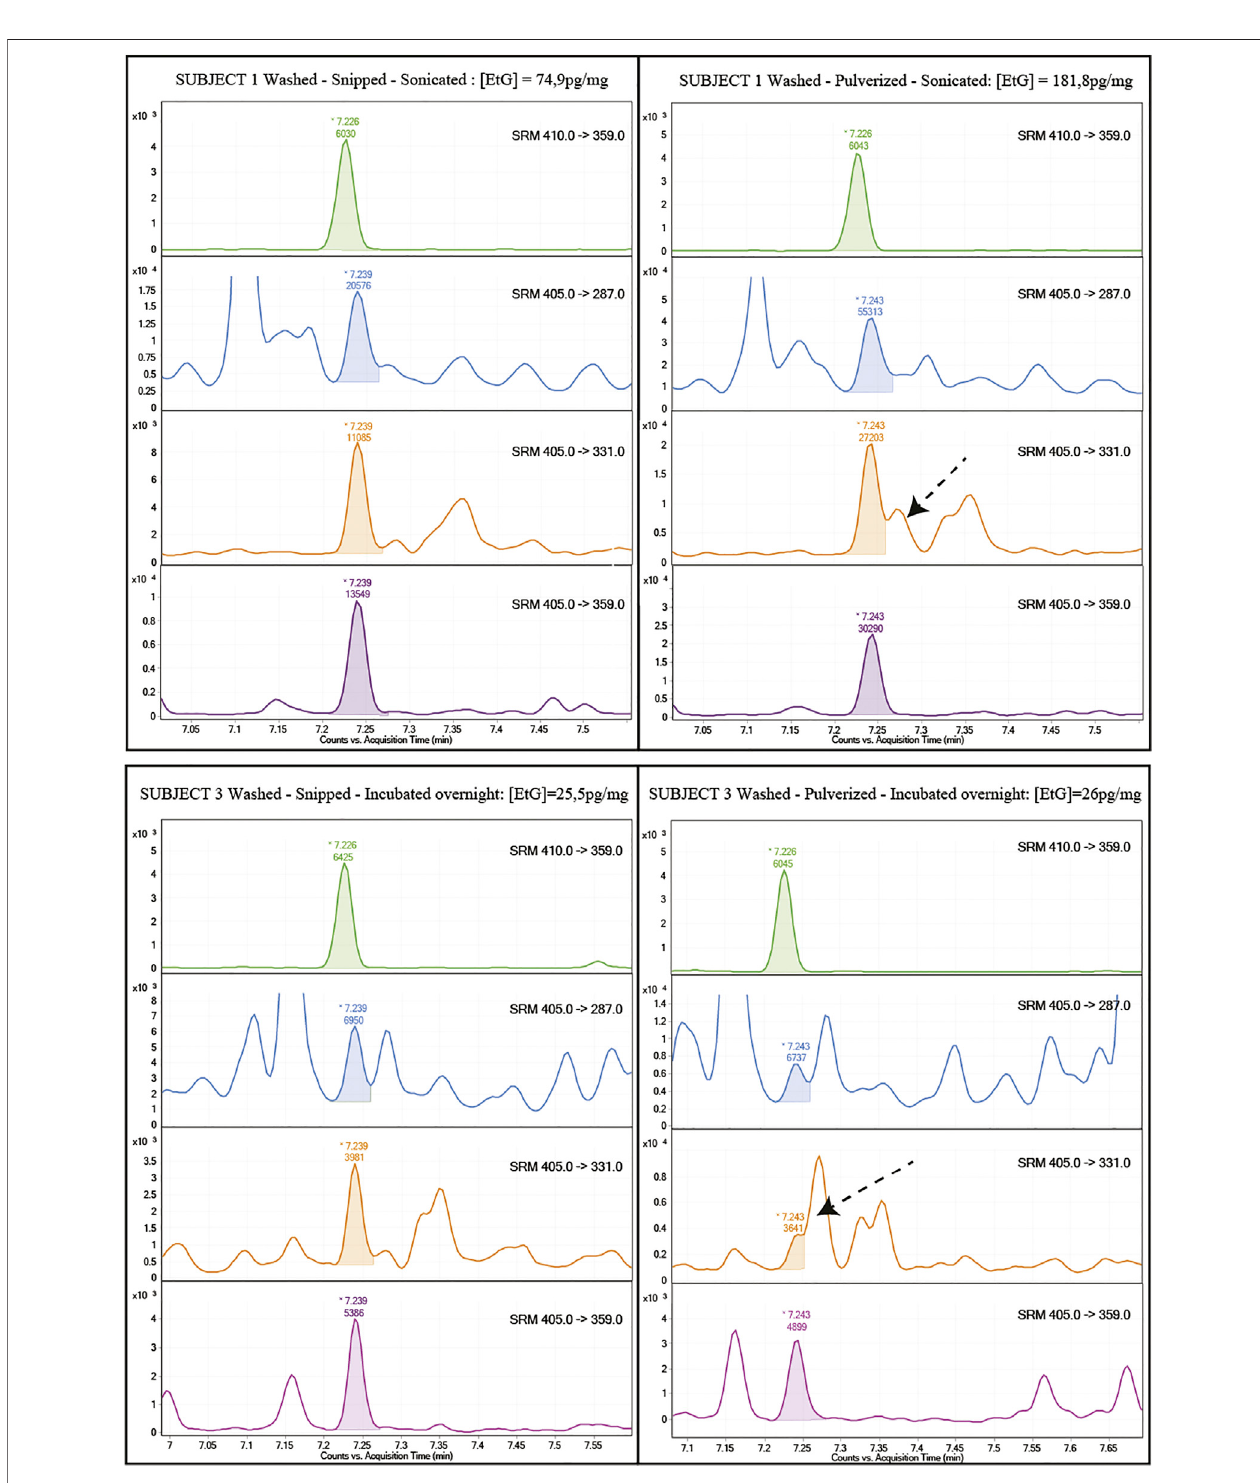
FIGURE2| Exampleofchromatogramsobtainedfromtheanalysisofthesame hairsample(top:subjectonetests “ a ” vs. “ ac ” ;bottom: subjectthreetests “ ab ” vs. “ abc ” ) pulverized or shredded. The arrow highlights the interference on the qualifying MRM 405 → 331 on pulverized samples regardless of the washing or incubation procedures (orange lines). Other MRMs were also reported for all tests.